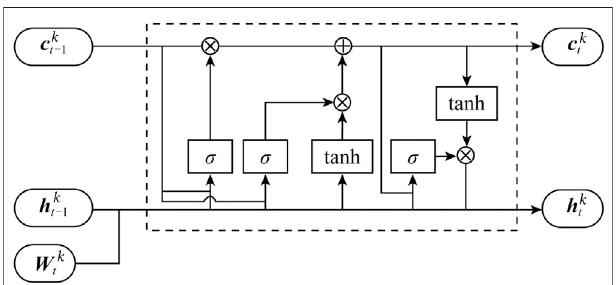
FIGURE 2 | Framework of forward LSTM